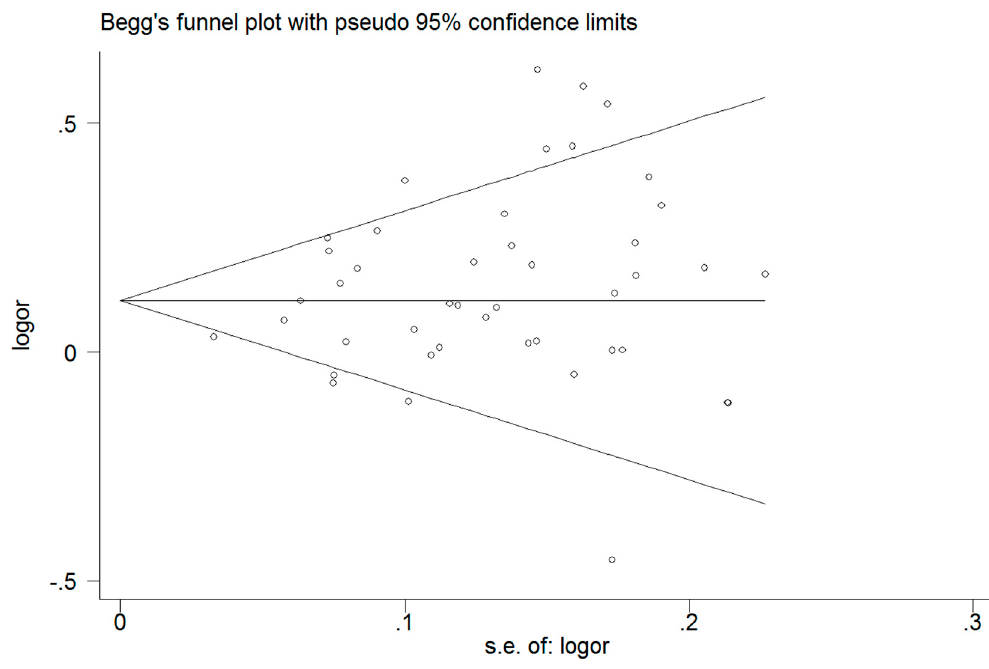
Figure 4. Funnel plot for allele comparison of atherosclerosis and the CETP TaqIB polymorphism. Each small circle represents a separate study for the indicated association.